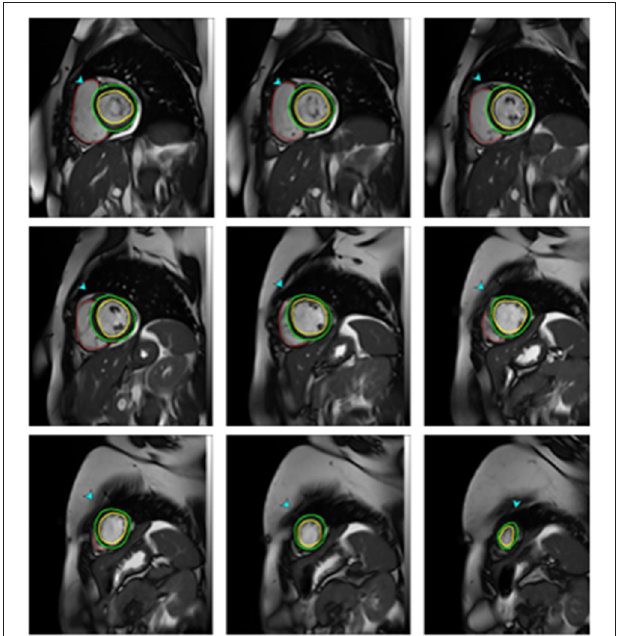
FIGURE 1 | CMR Measurements of ventricular volumes in one of mitral stenosis patients. End diastolic short-axis images from the apex to the base with epicardial (green lines) and endocardial (red lines) contours drawn for the left ventricle and endocardial contours for the right ventricle.